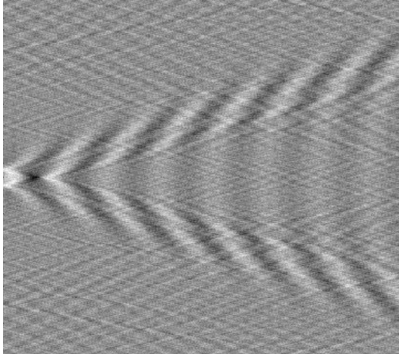
Figure 1. Kelvin wake pattern of aship velocity of 5 m/s.